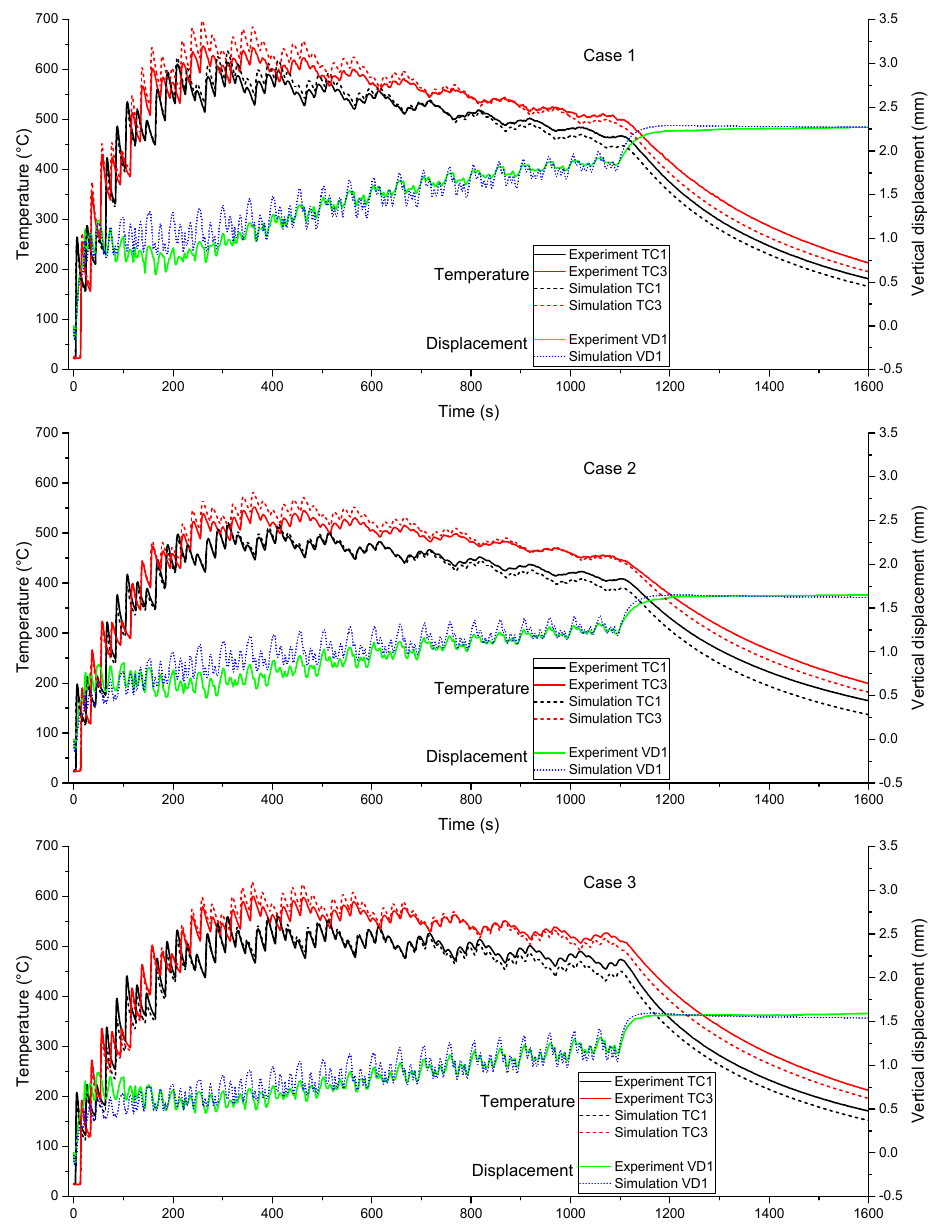
Figure 4. Comparison between calculated and experimental thermo-mechanical results of the rectangular parts under three different process parameters.